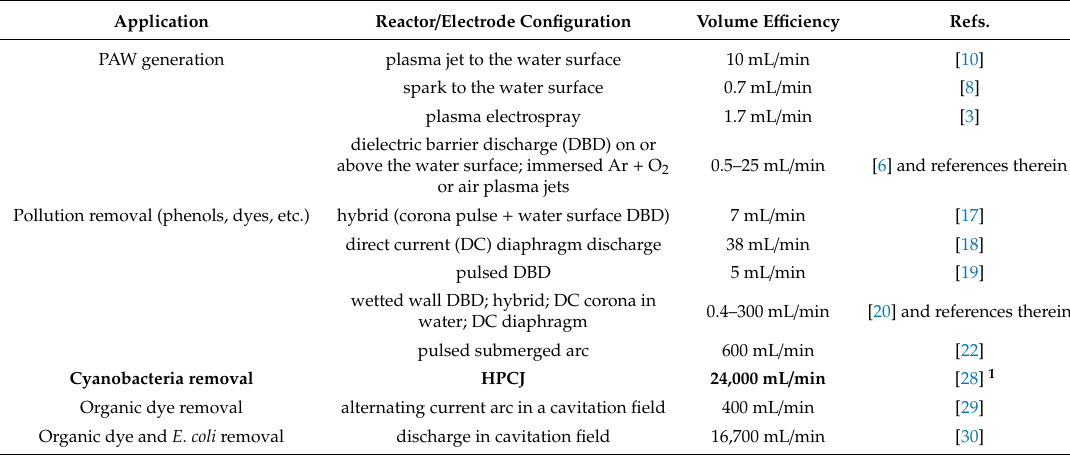
Table 1. Comparison of volume e ffi ciency of water treatment using various